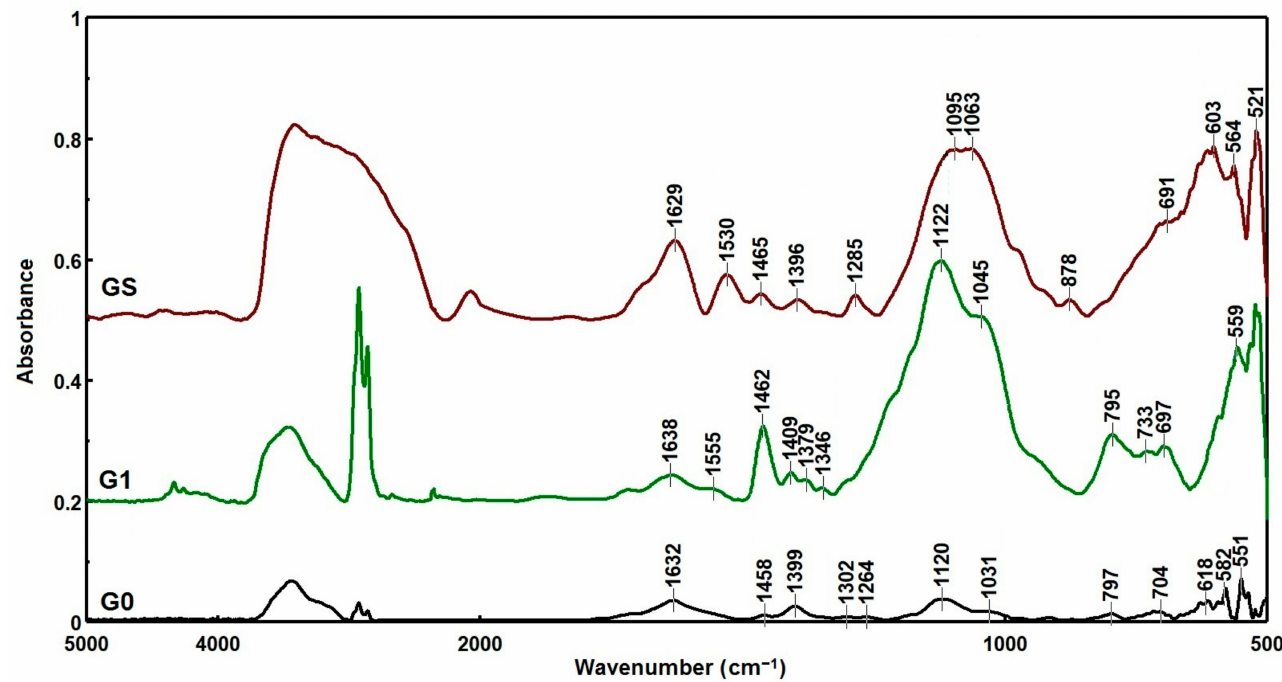
Figure 1. FTIR spectra of gentamicin sulfate (GS), SiO 2 NPs (sample G0), and silica-gentamicin nanostructured solution (sample G1), obtained as